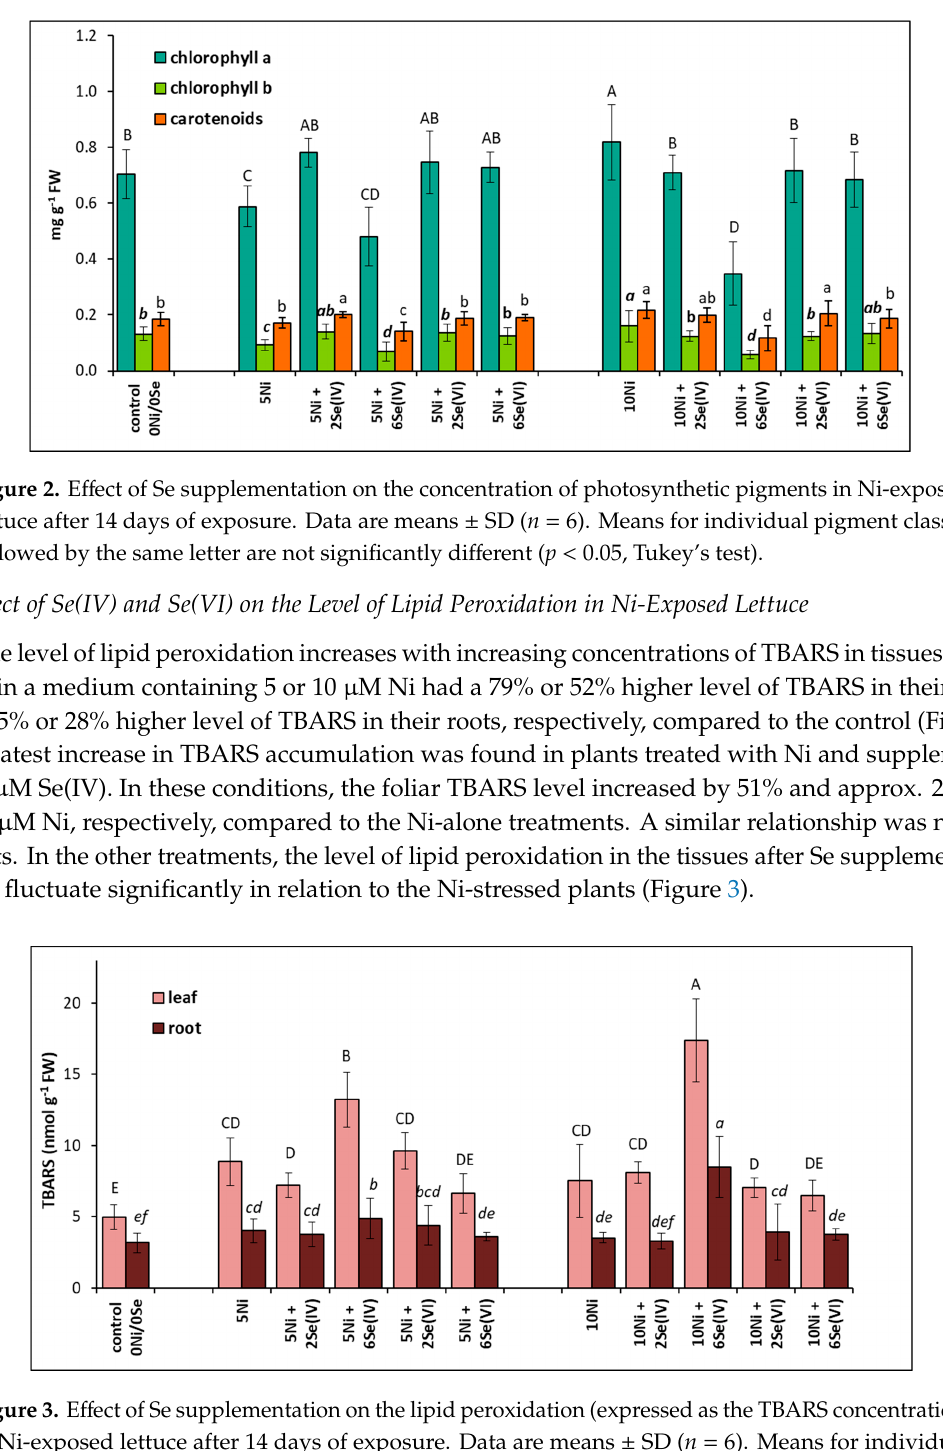
Figure 1. Effect of Se (selenite and selenate) supplementation on the growth parameters of Ni-exposed lettuce after 14 days of exposure. Data are means ± SD ( n = 24). Means for individual organs followed by the same letter are not significantly different ( p < 0.05, Tukey’s test).